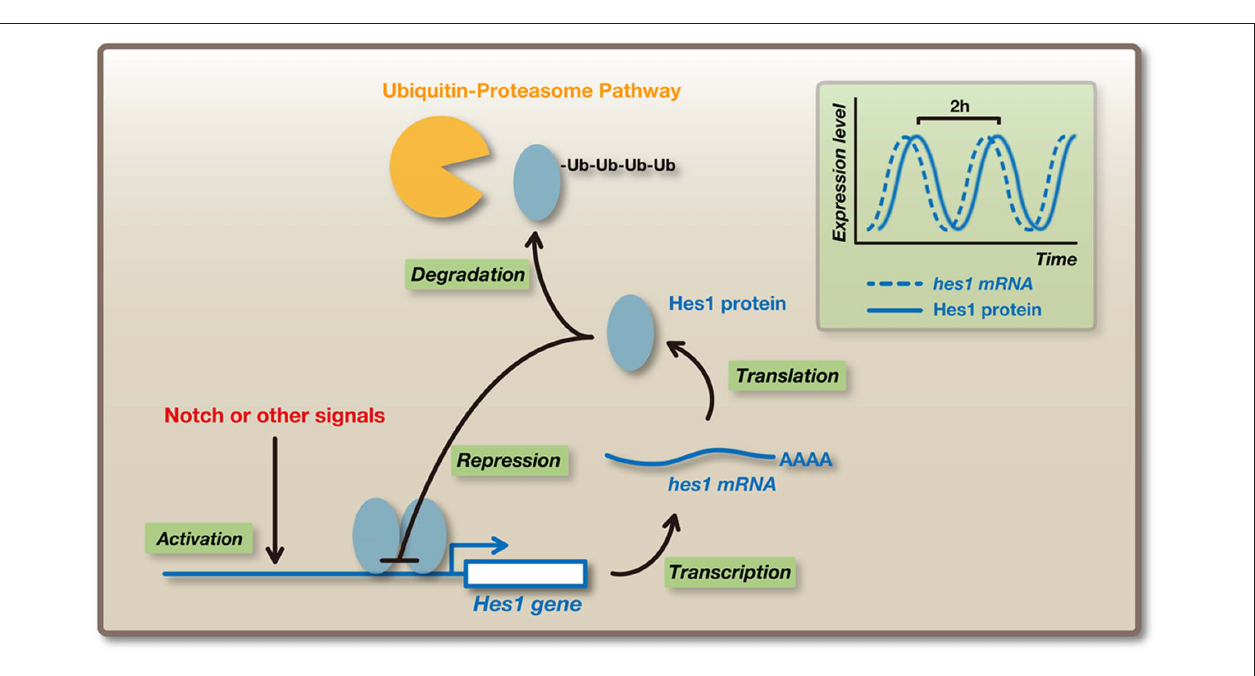
Figure 3 | Oscillatory expression of Hes1. Hes1 expression oscillates with a period of ∼ 2 h in many cell types such as neural stem/progenitor cells and fibroblasts. Hes1 represses its own expression by directly binding to its promoter.